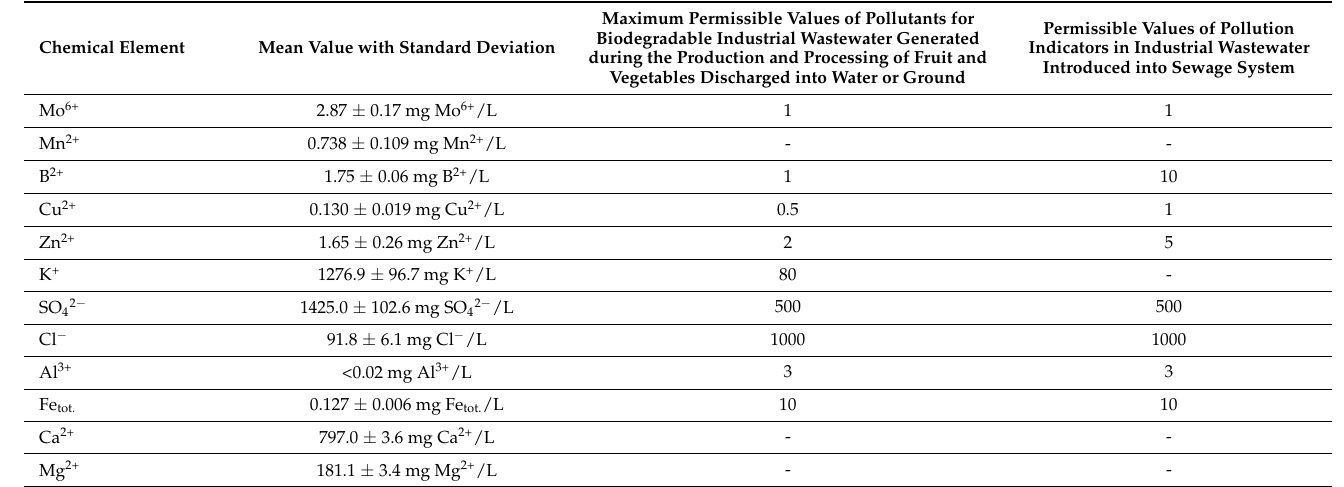
Table 1. The macronutrients- and micro elements’ concentration in the hydroponic wastewater, and their acceptable levels, according to Polish legislation [7,8].